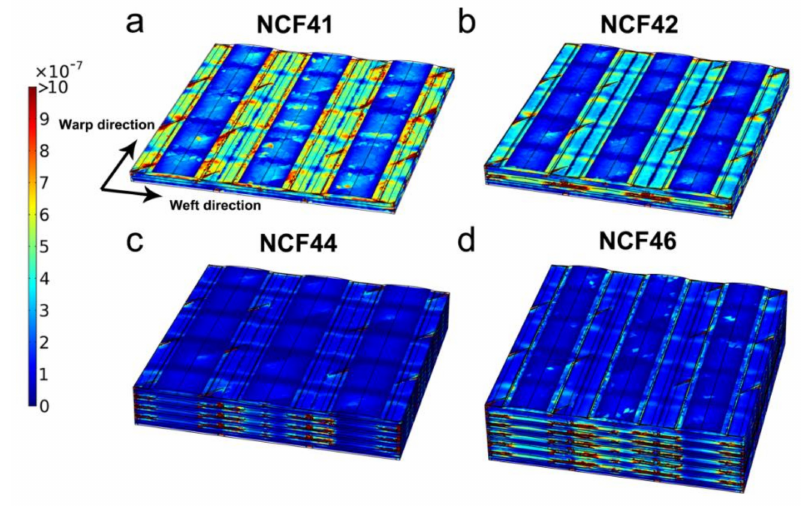
Figure 11. Flow velocity magnitudes in unit cells predicted by simulations. Table 8. Comparison of permeability calculated from simulations and permeability tested in